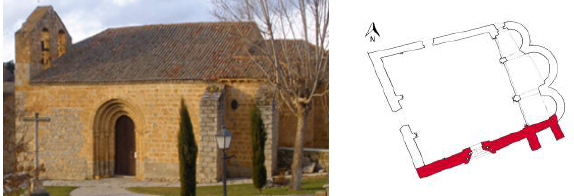
Figure 3. South façade of the Church of San Segundo in Ávila (Spain).